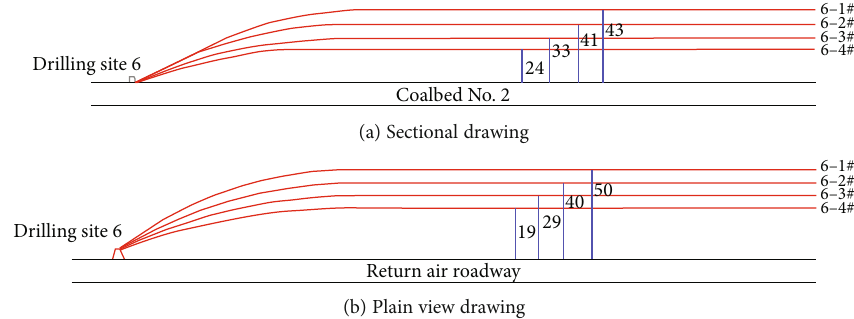
Figure 11: High-level directional long drilling layout of the 6# drilling